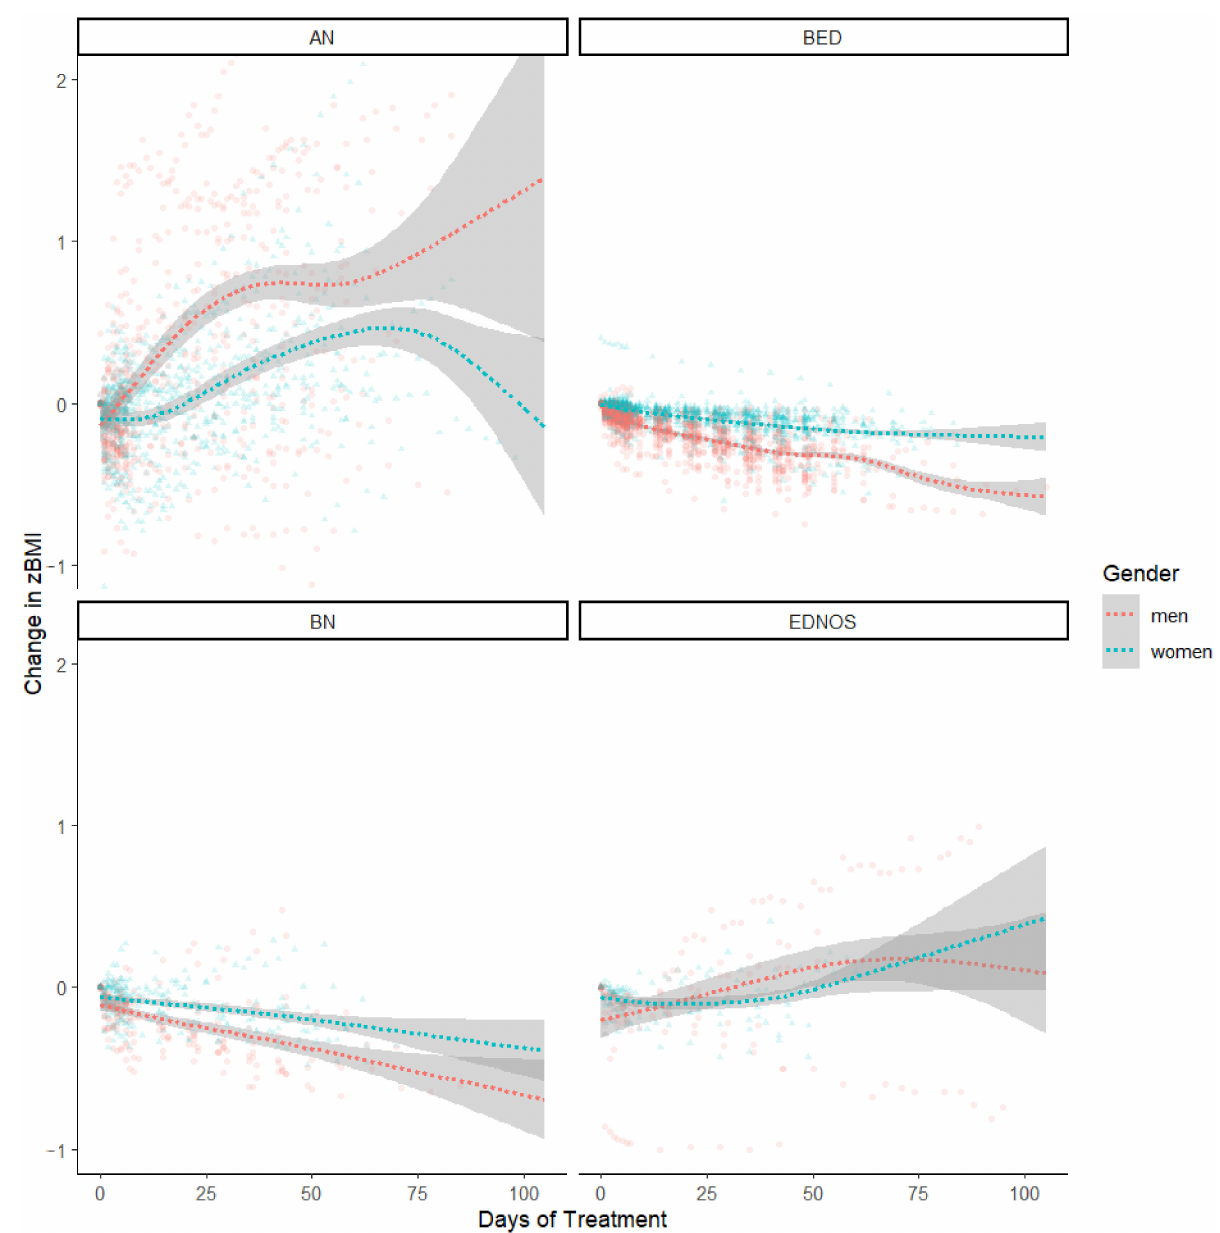
Figure 1. Patients’ weight trajectories, i.e., the time-dependent changes in age- and gender- standard- ized (zBMI) from admission to different timepoints during treatment (zBMI timepoint –zBMI admission ), as a function of gender, ED group, and treatment timepoint. Curved regression lines (with 95% confidence bands) were fitted using function geom_smooth(), method (“gam”), as imple- mented in R package ggplot2 v. 3.3.5 (R Core Team, Vienna, Austria) [74]. ED = Eating Disorder, AN = Anorexia Nervosa, BN = Bulimia Nervosa, BED = Binge Eating Disorder, EDNOS = Eating Disorder Not Otherwise Specified, BMI = body mass